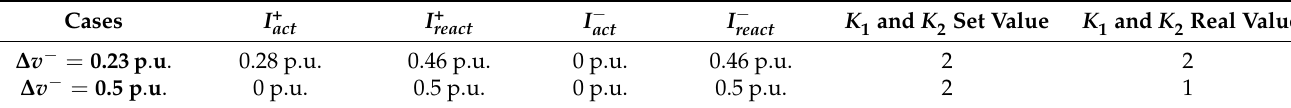
Table 3. Summary of the results obtained under unbalanced